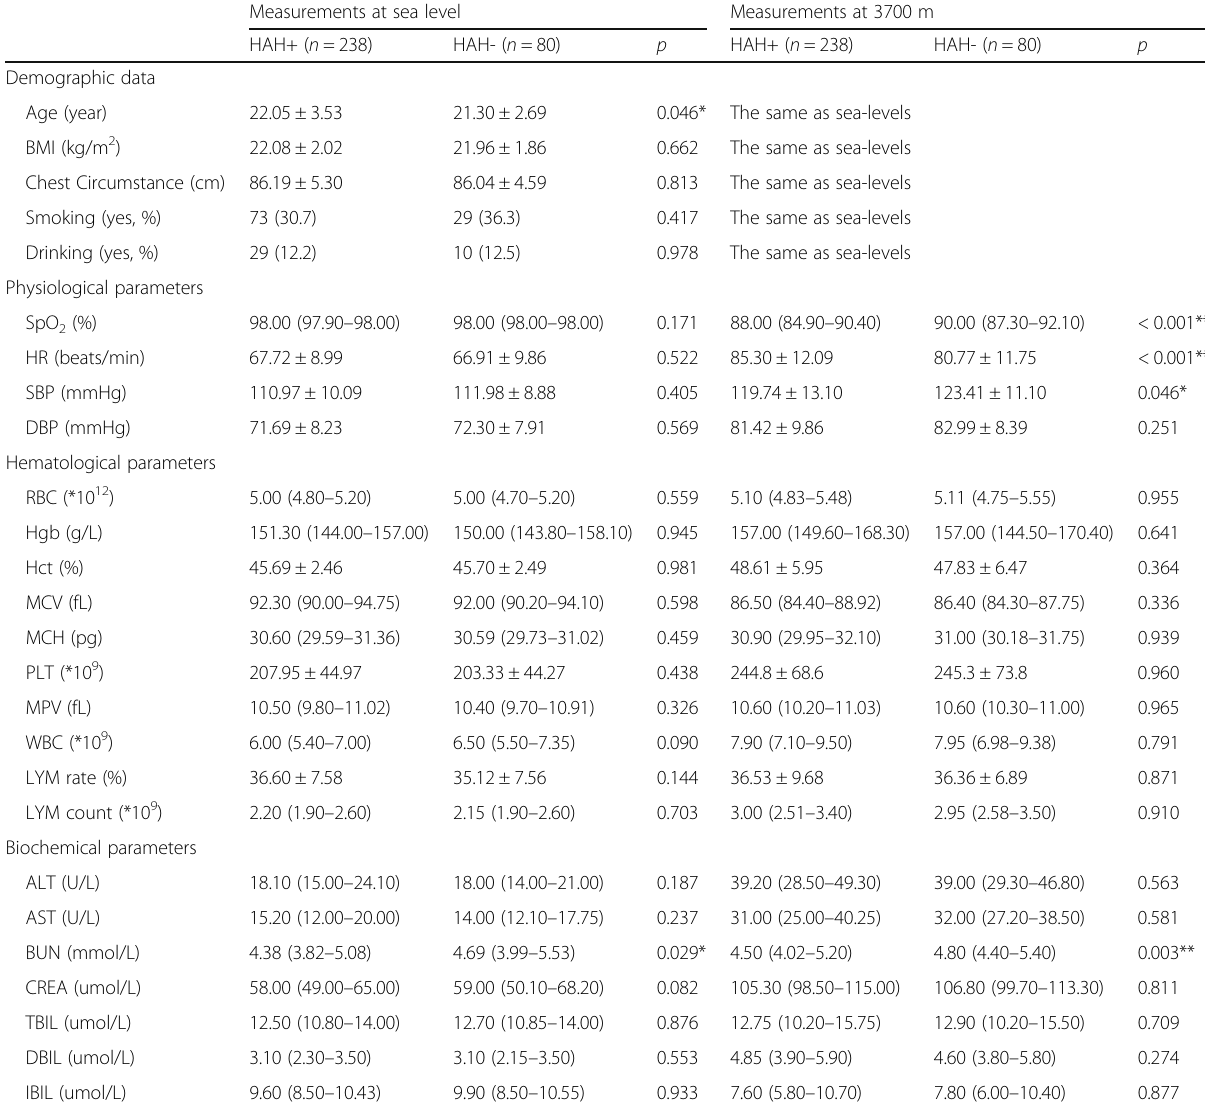
Table 2 Difference between HAH+ and HAH- subjects in demographics, physiological, hematological and biochemical parameters at sea level and 3700